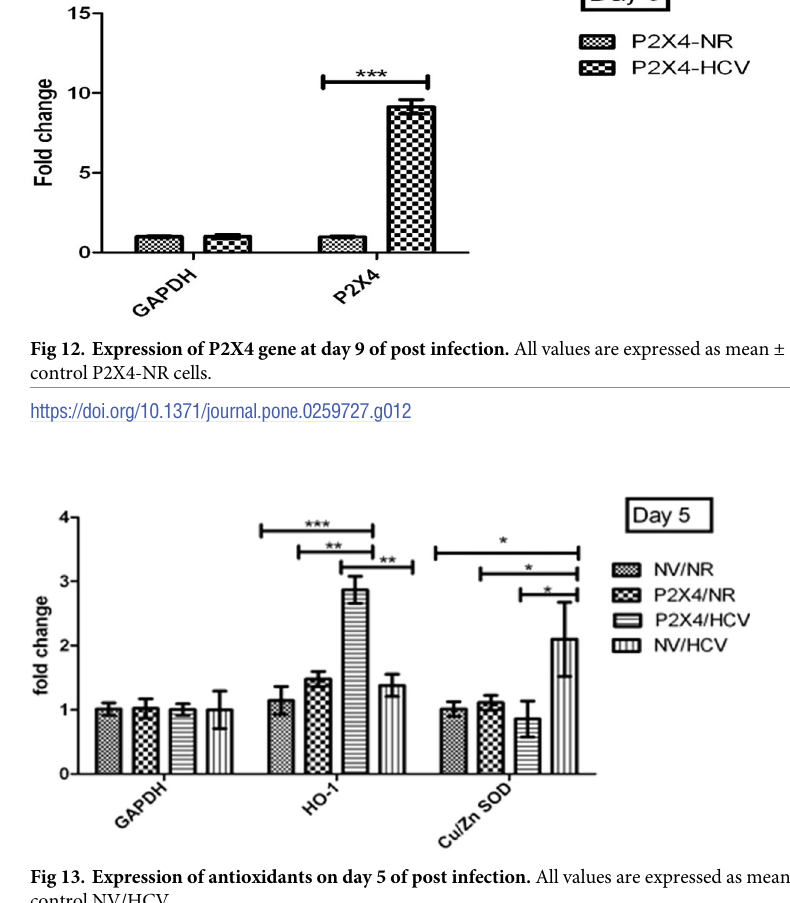
PLOS ONE | https://doi.org/10.1371/journal.pone.0259727 May 20,